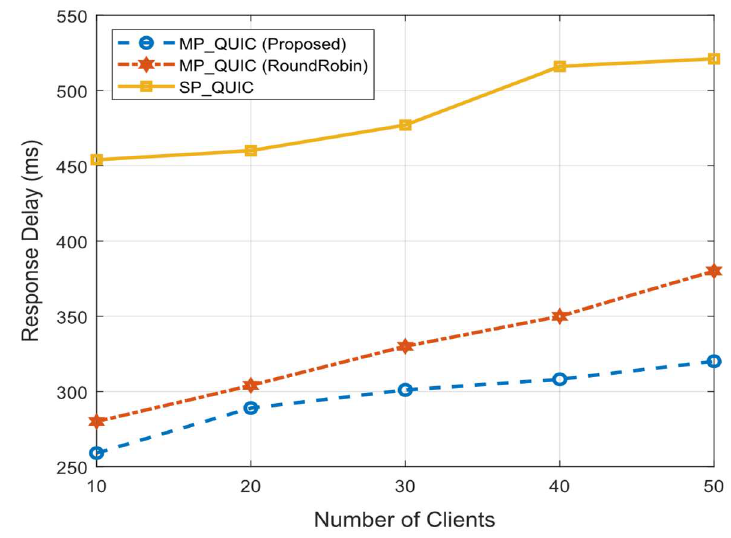
Figure 10. Comparison of response delays for different number of clients.